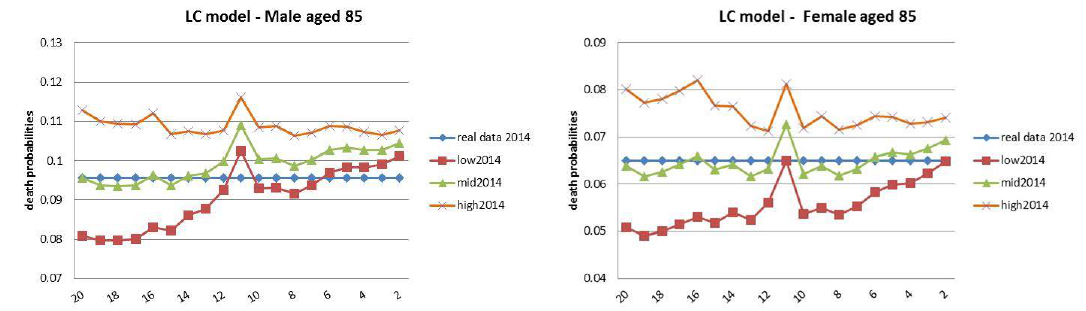
Figure 20. LC Rolling Fixed-Length Horizon Backtests (age 85): convergence to real data